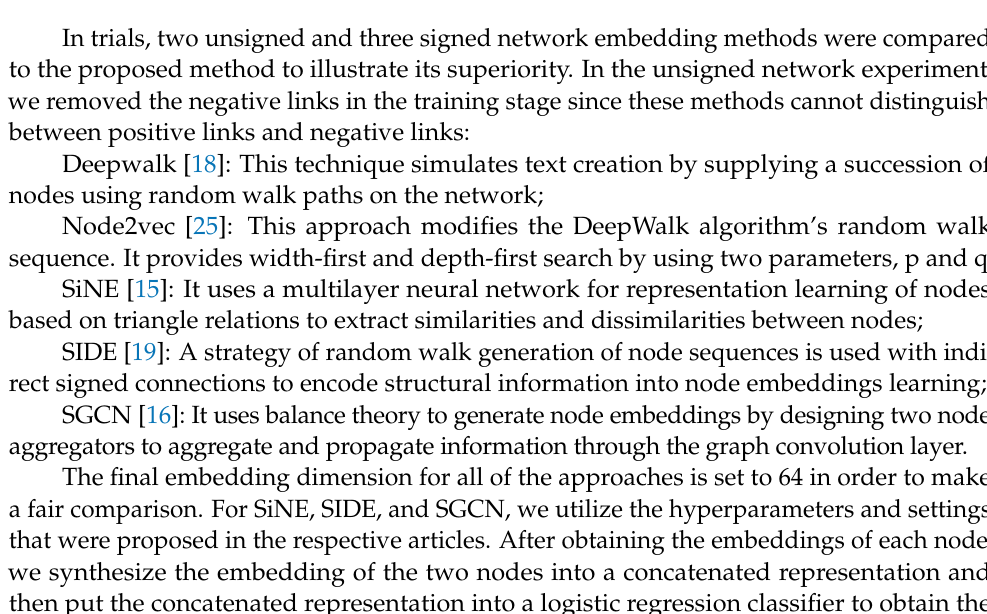
Table 1. Statistic of the datasets. Datasets Nodes Positive Links Negative Links Bitcoin-Alpha 3783 22,650 1536 Bitcoin-OTC 5881 32,029 3563 Wikirfa 10,835 138,813